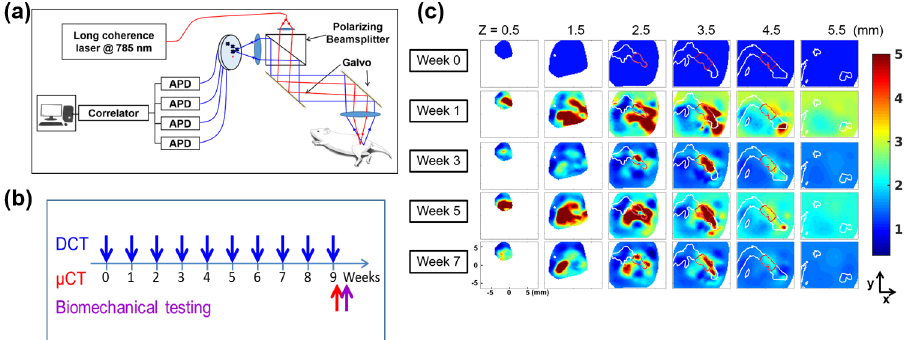
Fig 1. DCT measurements and results. (a) DCT optical measurement system set-up (modified from figure in ref [17]); (b) The timeline of measurements for each mouse; (c) An example of the three-dimensional relative blood flow ( rBF )changes in a mouse with an allograft (Mouse 10). Each row shows the z-slice of the three-dimensional rBF distribution at each week and each column shows the temporal changes for a specific z-slice. The borders of the bones and graft are outlined with white and red lines, respectively. Note that weekly DCT measurements were made, but only results from selected weeks are shown here.